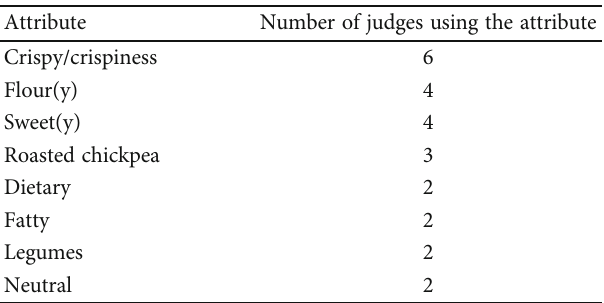
Table 5: Sensory attributes generated and used by more than one